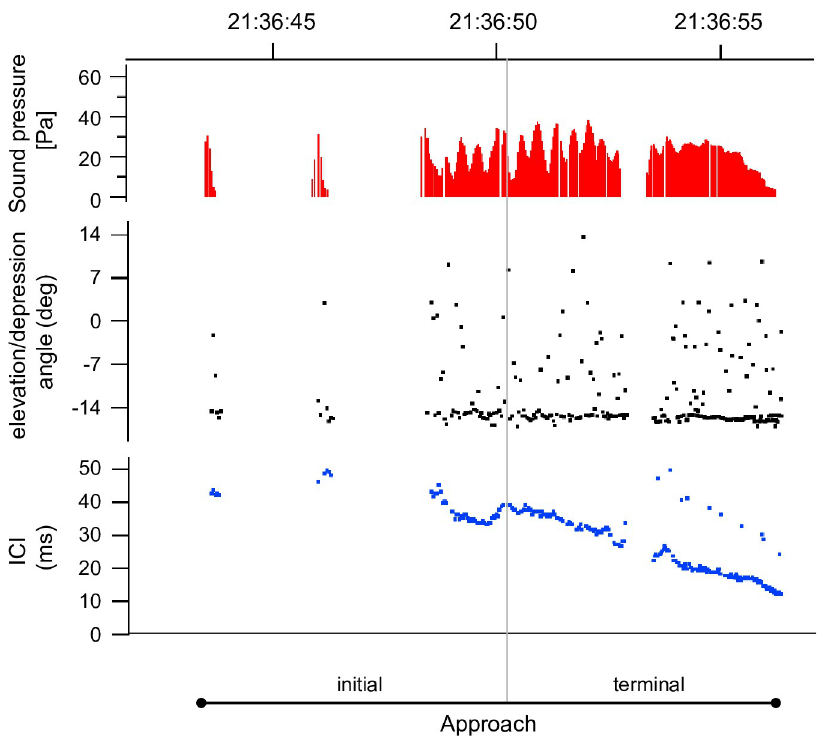
Fig 5. An example of foraging sequences recorded around the bottom-gillnet on 22 July 2016. Time-series for sound pressure, elevation/depression angle, and inter-click interval are shown. https://doi.org/10.1371/journal.pone.0246838.g005 extreme cases, the presence duration exceeded 1 h—too long for a porpoise to be just passing along the net. Based on the results, it is suggested that harbour porpoises often stayed around the net, rather than just appearing as they passed by, even when no bycatch occurred.